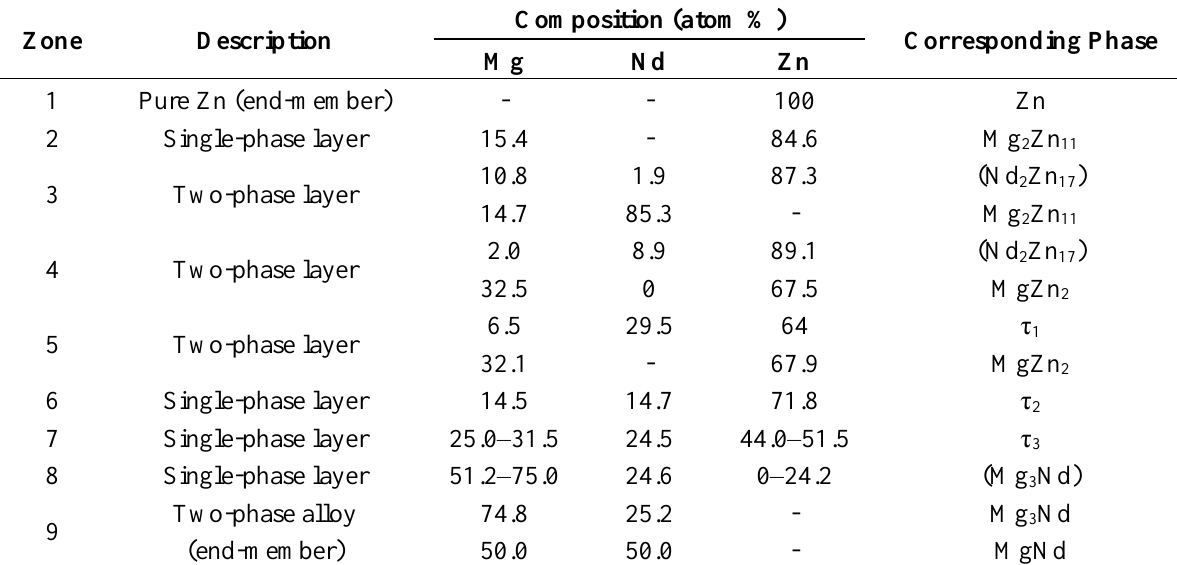
Table 1. WDS spot analysis of different diffusion zones of the diffusion couple